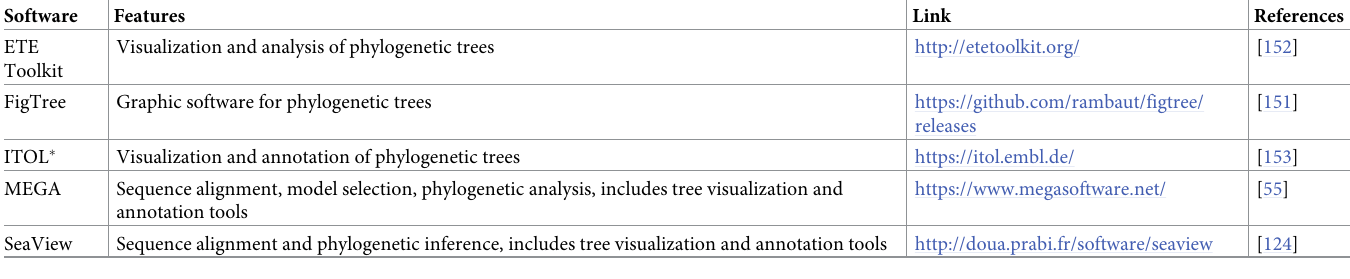
Table 8. List of tools for graphical visualization and annotation of phylogenetic trees.